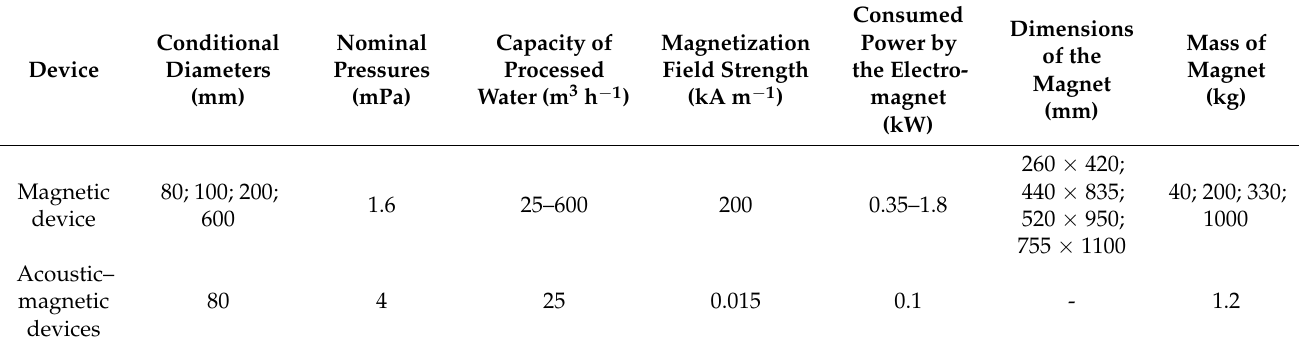
Table 6. Parameters of reagent-free water treatment units.